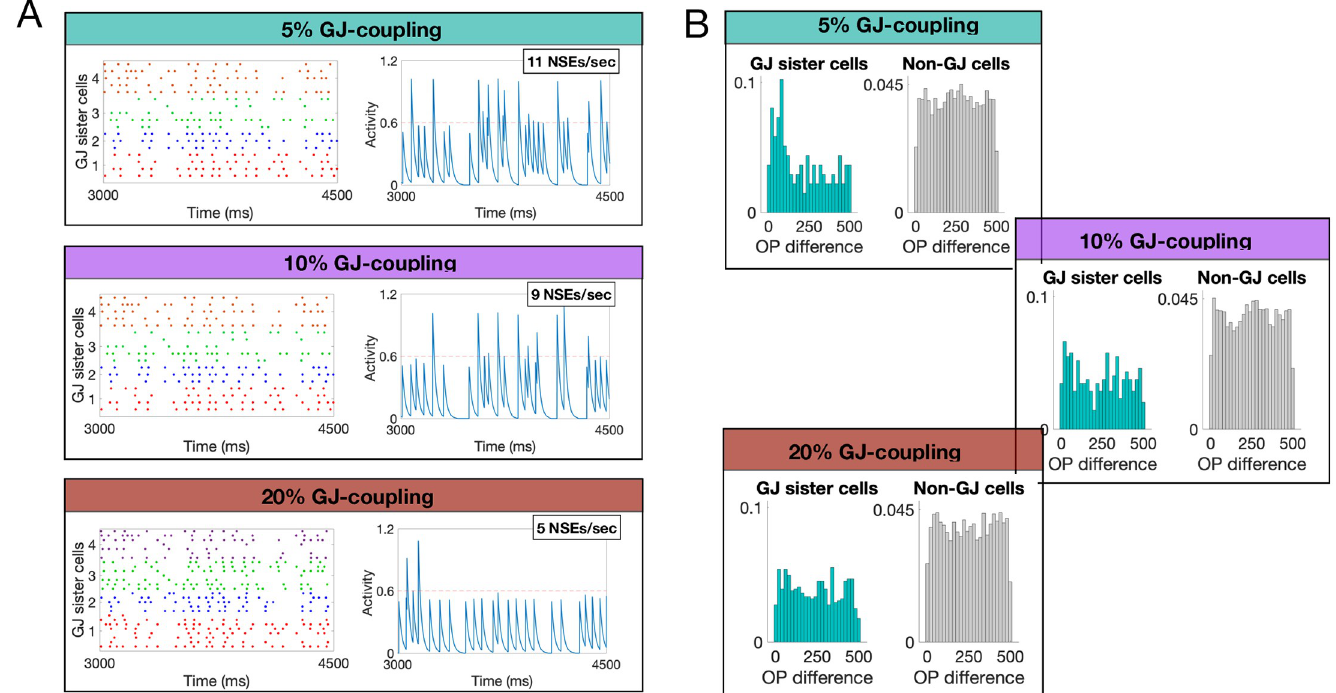
Fig 8. A : Sample raster plots (left) and average activity (right) of sets of GJ-coupled sister cells for different GJ coupling percentages. Each color-coded set of spike times in the raster plots indicate a set of GJ-coupled sister cells. The activity plots shown to the right corresponds to the GJ-coupled set shown in red in each raster plot. The average activity plots were created by adding an exponential tail of 20 ms to each spike for each cell in the GJ group, adding them together, and dividing by the number of cells in each group. The average number of network synchronous events (NSEs) per second, a measure for the amount of synchrony, for each coupling percentage, is shown in text on the average voltage plots in A . The threshold for determining an NSE was chosen as 0.6, as illustrated by the red dashed line, though small changes in this threshold do not significantly affect the results. B : The difference in OP for GJ-coupled cells (teal) and non-GJ-coupled cells (grey) in a network with 5%, 10%, and 20% GJ coupling among sister cells (top to bottom).